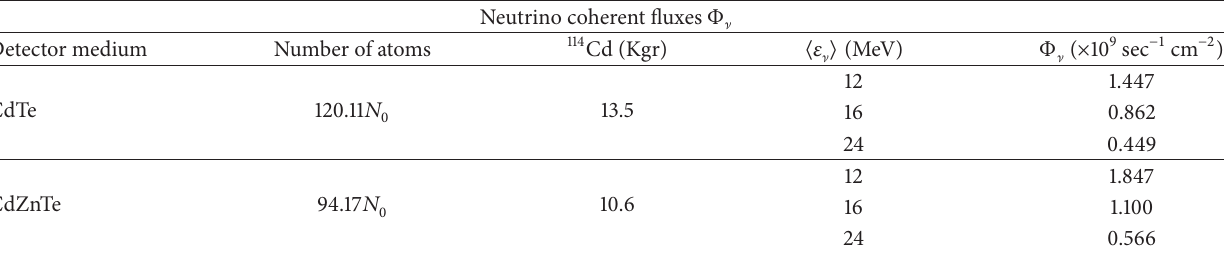
Table 4: Neutrino coherent fluxes Φ ] (𝜀 ] ) (in units 10 9 sec −1 cm 2 ) for 114 Cd isotope for the two materials (CdTe and CdZnTe) of the COBRA experiment obtained in the case of supernova neutrinos with mean energies ⟨𝜀 ] ⟩ = 12, 16, and 24 MeV. 𝑁 0 is the Avogadro’s